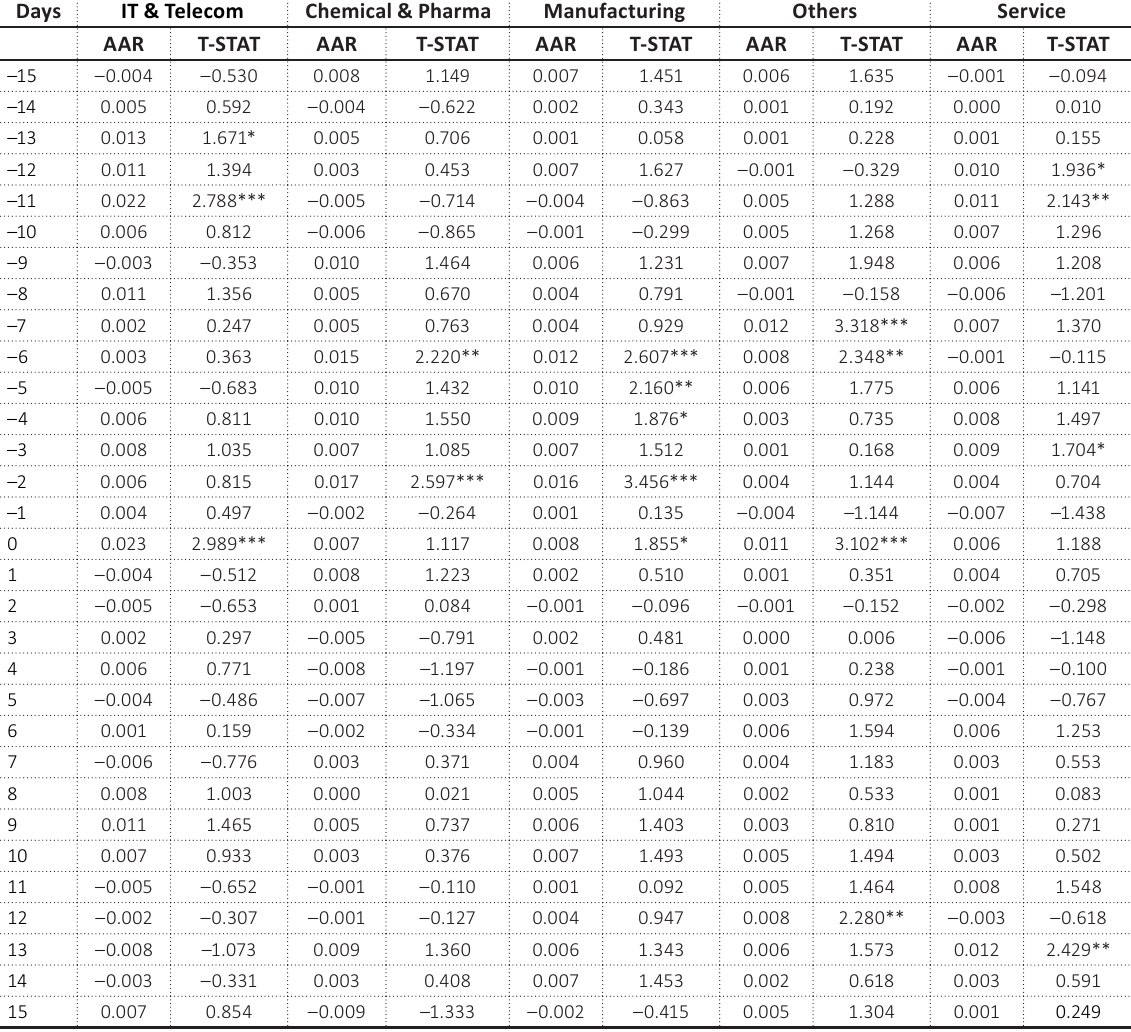
Table 4. AAR and T-STAT values for different